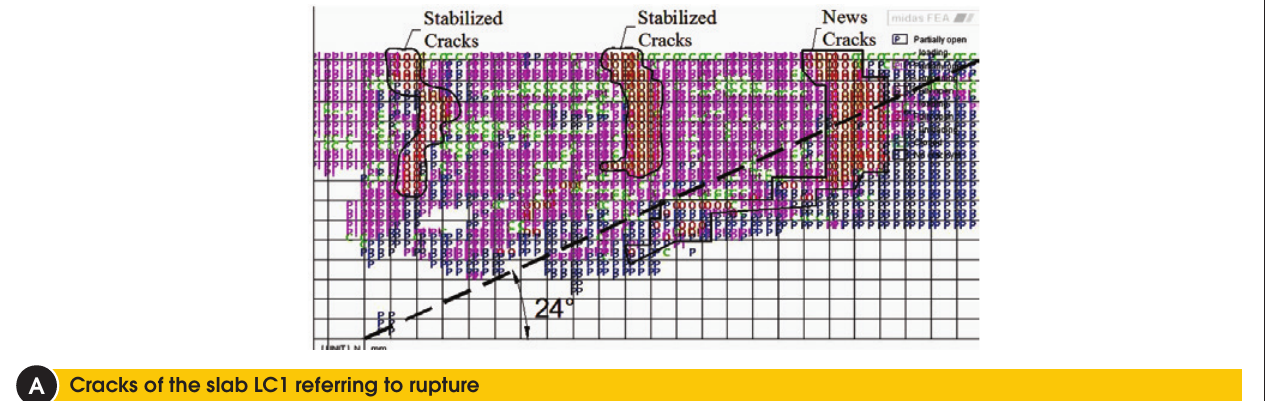
Figure 14 – Cracks observed in instant of the rupture in slabs models LC1, LC2, LC3 and